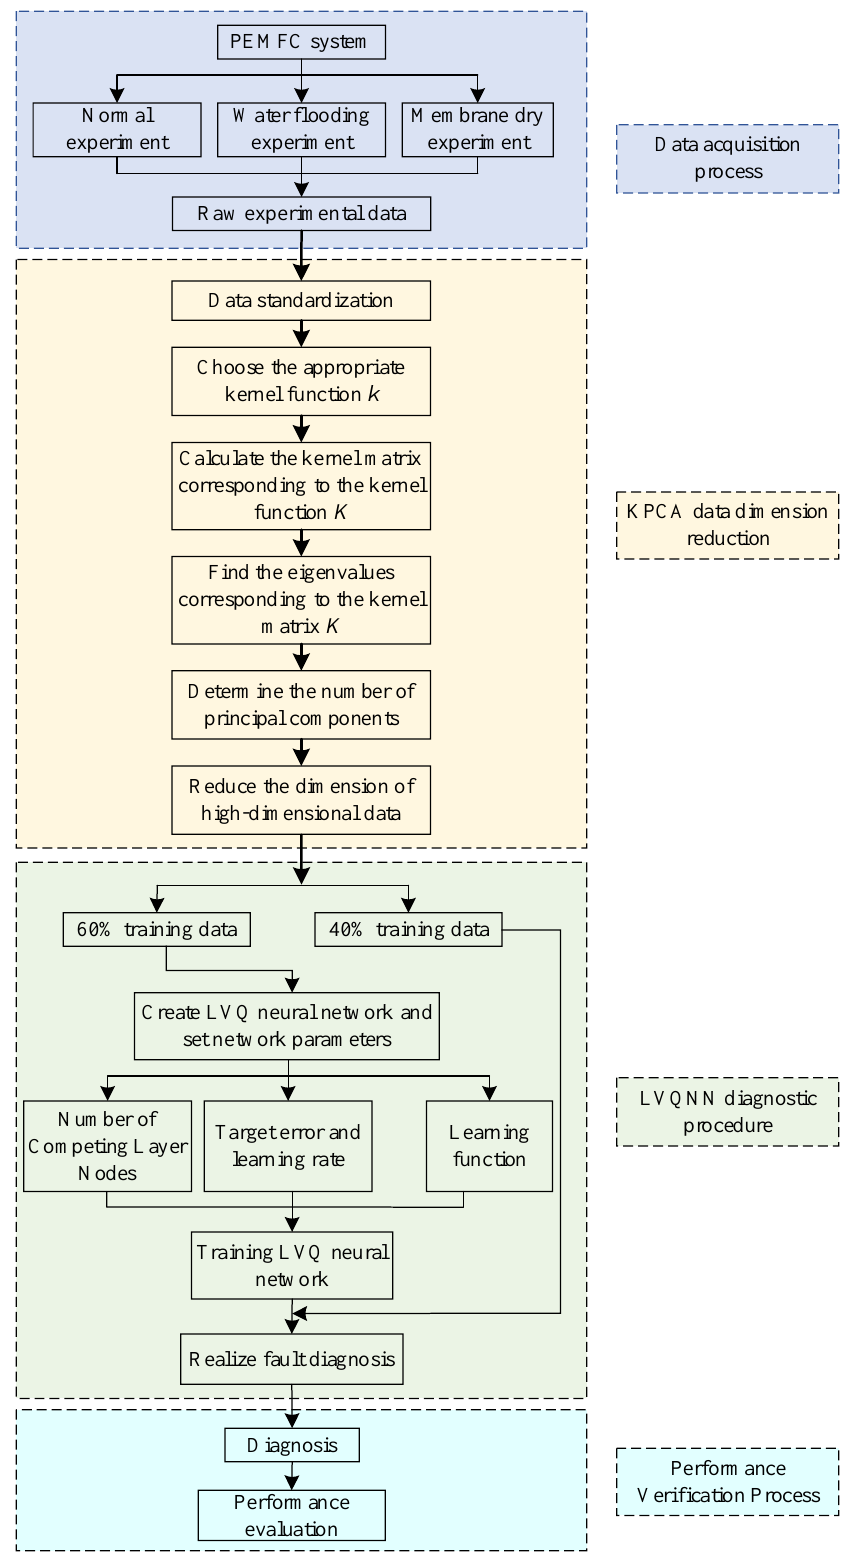
Figure 4. Fault diagnosis process of PEMFC water management based on kernel principal component analysis (KPCA)-LVQNN.